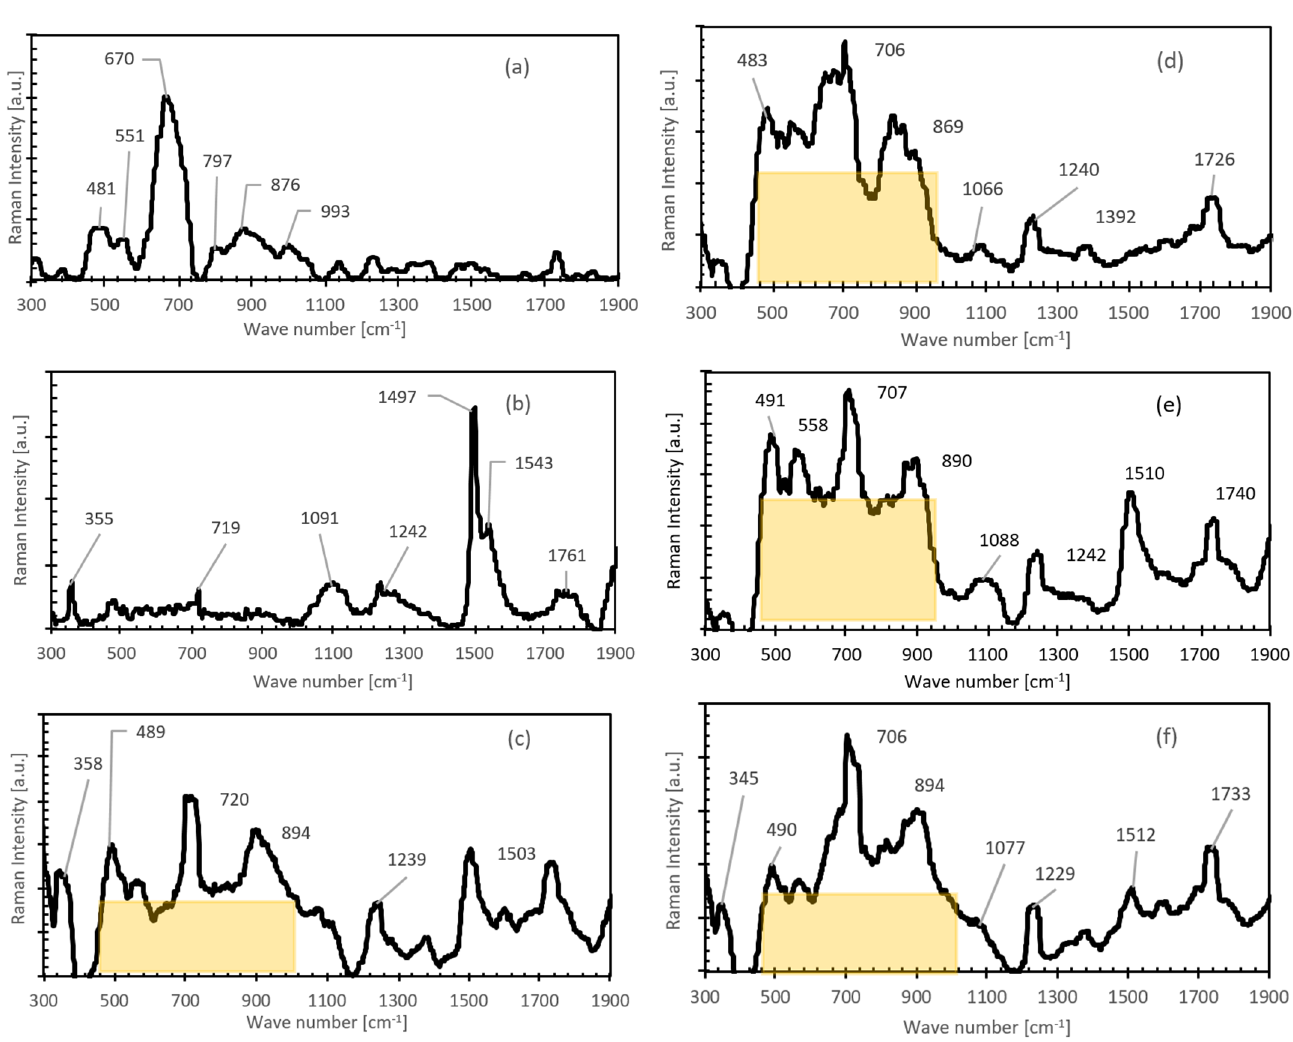
Figure 4. Raman spectra of volcanic ash and pure lime are shown in the bottommost spectra ( a ) and ( b ), respectively. Remaining Raman spectra represent aged cementing mortars prepared in different ratios of lime/ash; 0.86 in Figure ( c ), 0.67 in Figure ( d ), 0.55 in Figure ( e ), and 0.40 in Figure ( f ), arranged in the decreasing quantity of lime content in the mortar. Spectral positions of the major Raman peaks are marked and labeled adjacent to the peak in the units of cm − 1